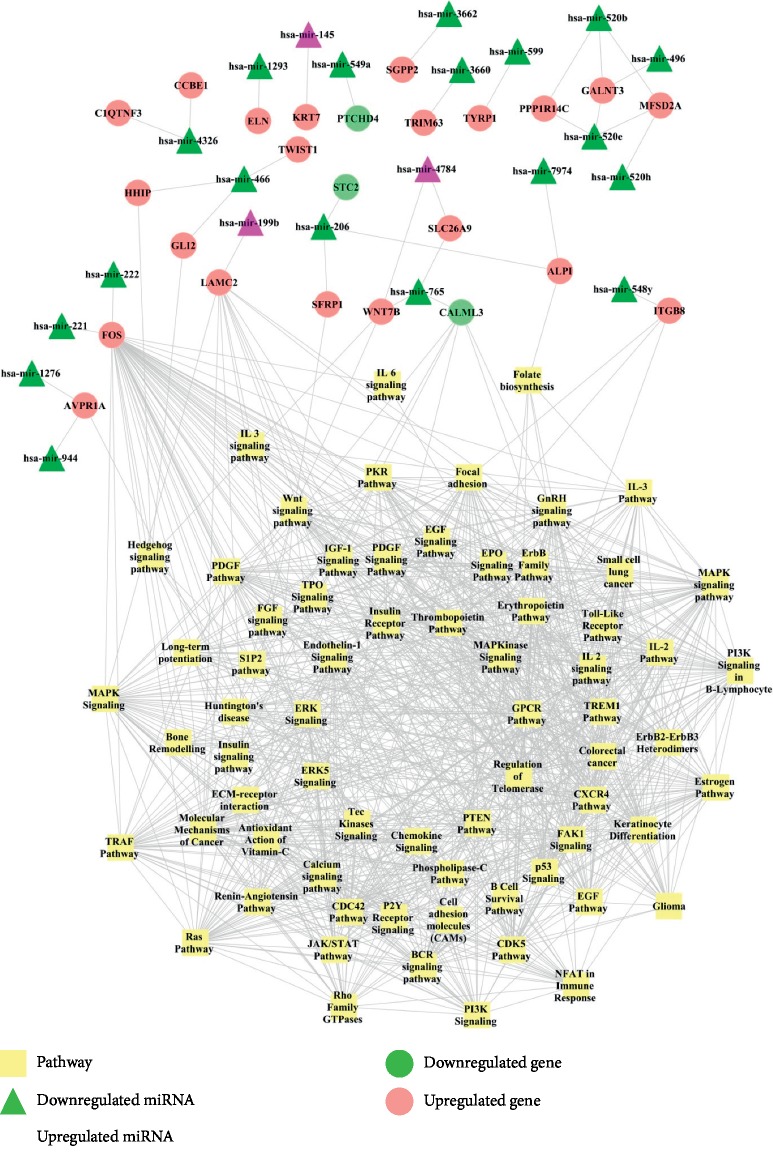
Elucidation of miRNA-mRNA-pathway network in liver cancer.